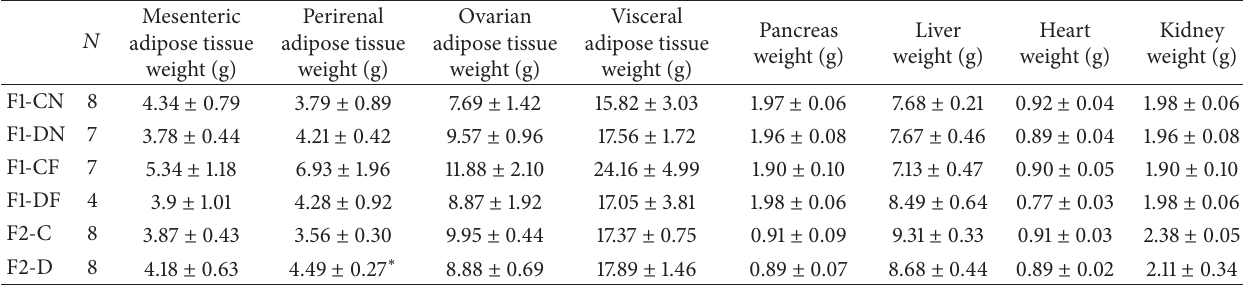
Table 2: Body composition (grams) of F1 and F2 females at 28